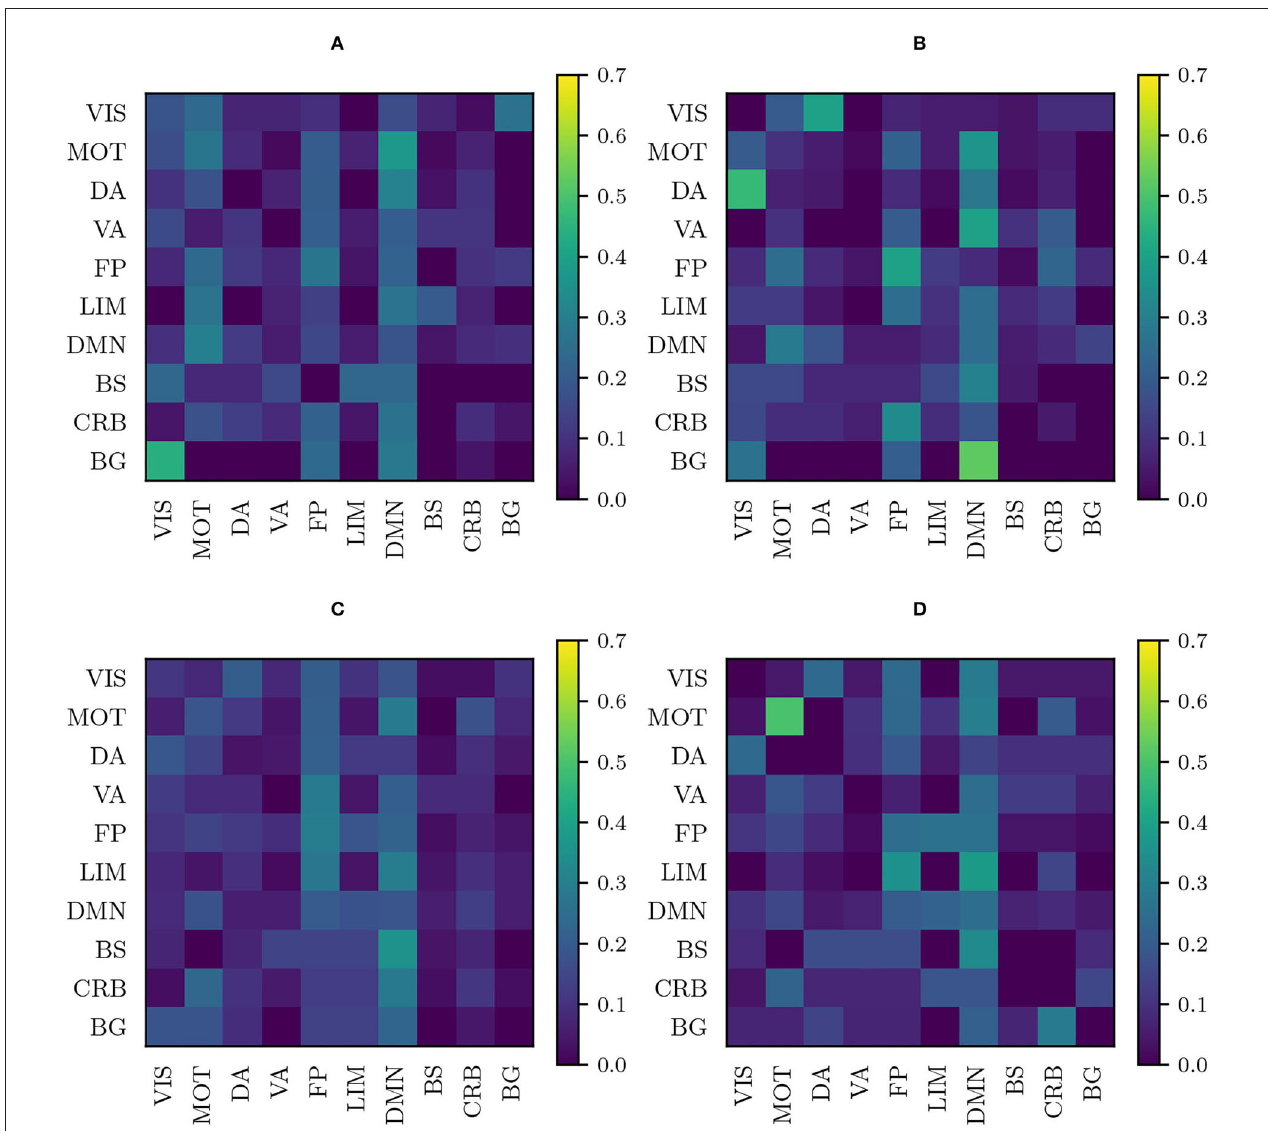
FIGURE 7 | Anomaly distribution plots according to the involved functional components obtained as described in subsection 3.4 using (A) original matrices; (B) matrices transformed under Rigid Log-Euclidean Translation (RLET) to the global mean 6 ; (C) matrices transformed under matrix whitening; (D) matrices transformed under RLET to the identity matrix. VIS, visual network; MOT, sensorimotor network; DA, dorsal attention network; VA, ventral attention network; FP, frontoparietal network; LIM, limbic network; DMN, default mode network; BS, brain stem; CRB, cerebellum; BG, basal